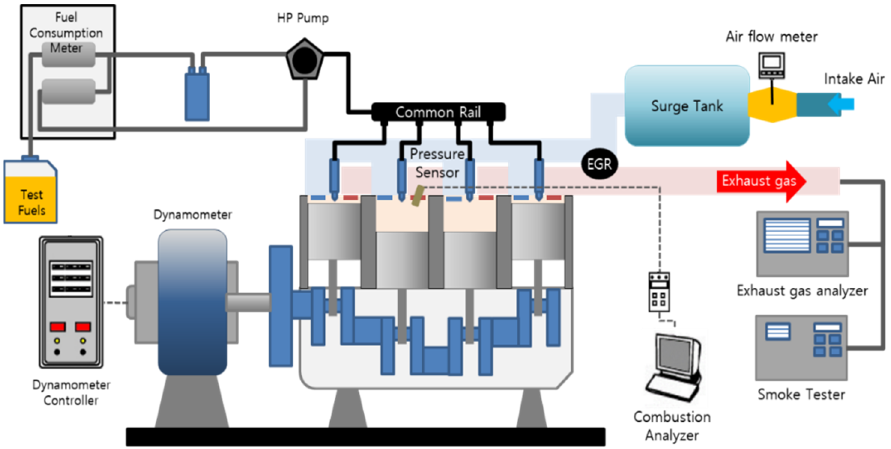
Figure 1. Schematic diagram of the experimental setups.